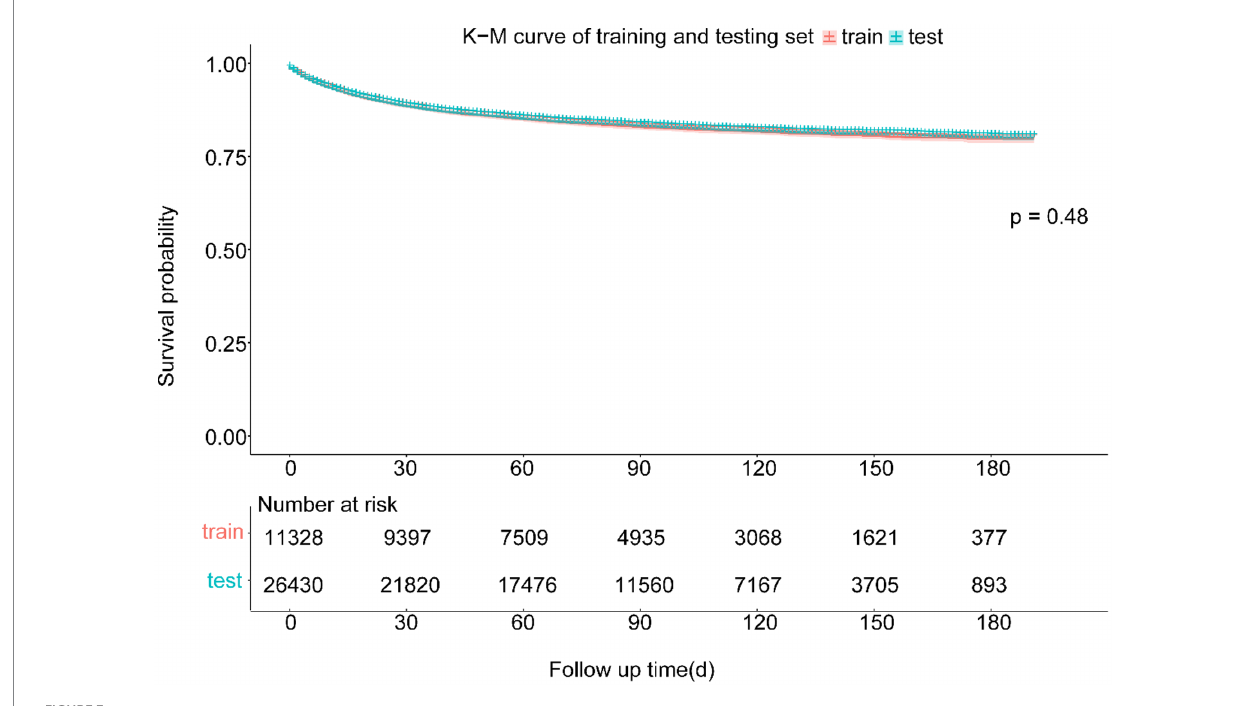
FIGURE 3 Kaplan–Meier curve of training and testing cohort. There was no statistically significant difference between the survival of training and testing cohort in the log-rank test ( p = 0.48).